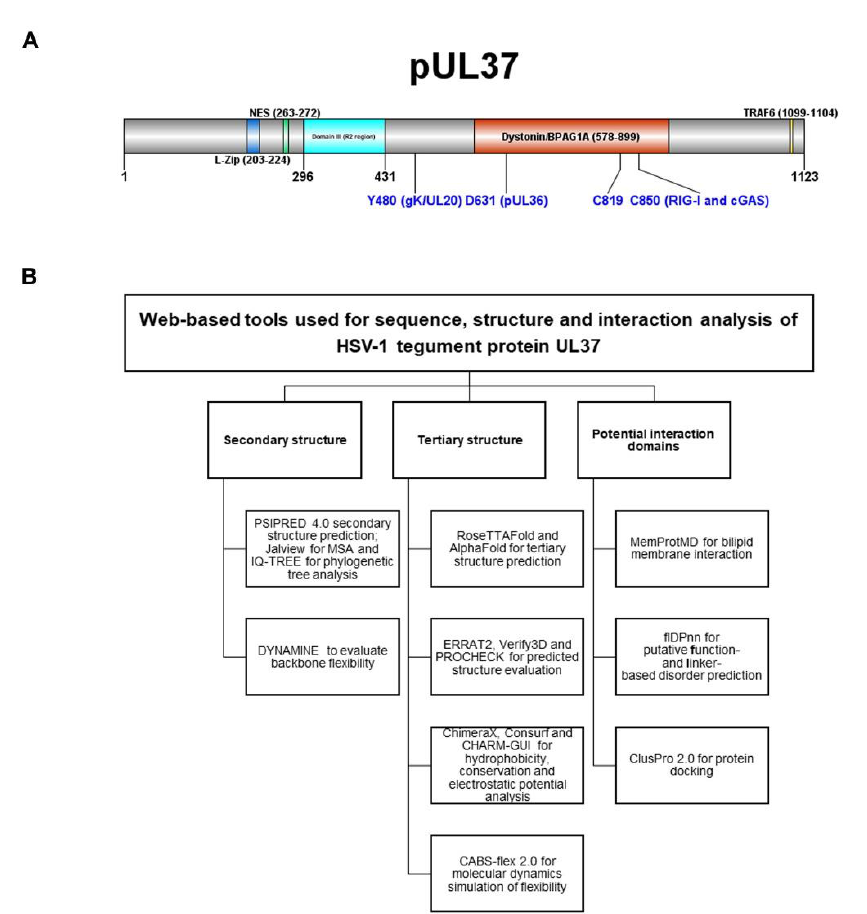
Figure 1. ( A ) Schematic diagram of HSV-1 UL37 tegument protein functional domains. Amino- and carboxy-termini show previously identified functional domains for viral replication and innate immune regulation. ( B ) Multiple web-based computational tools and software used for sequence predicted structure and interaction analysis of tegument protein UL37. Webservers and software are grouped according to secondary and tertiary structure and interaction domain analysis.